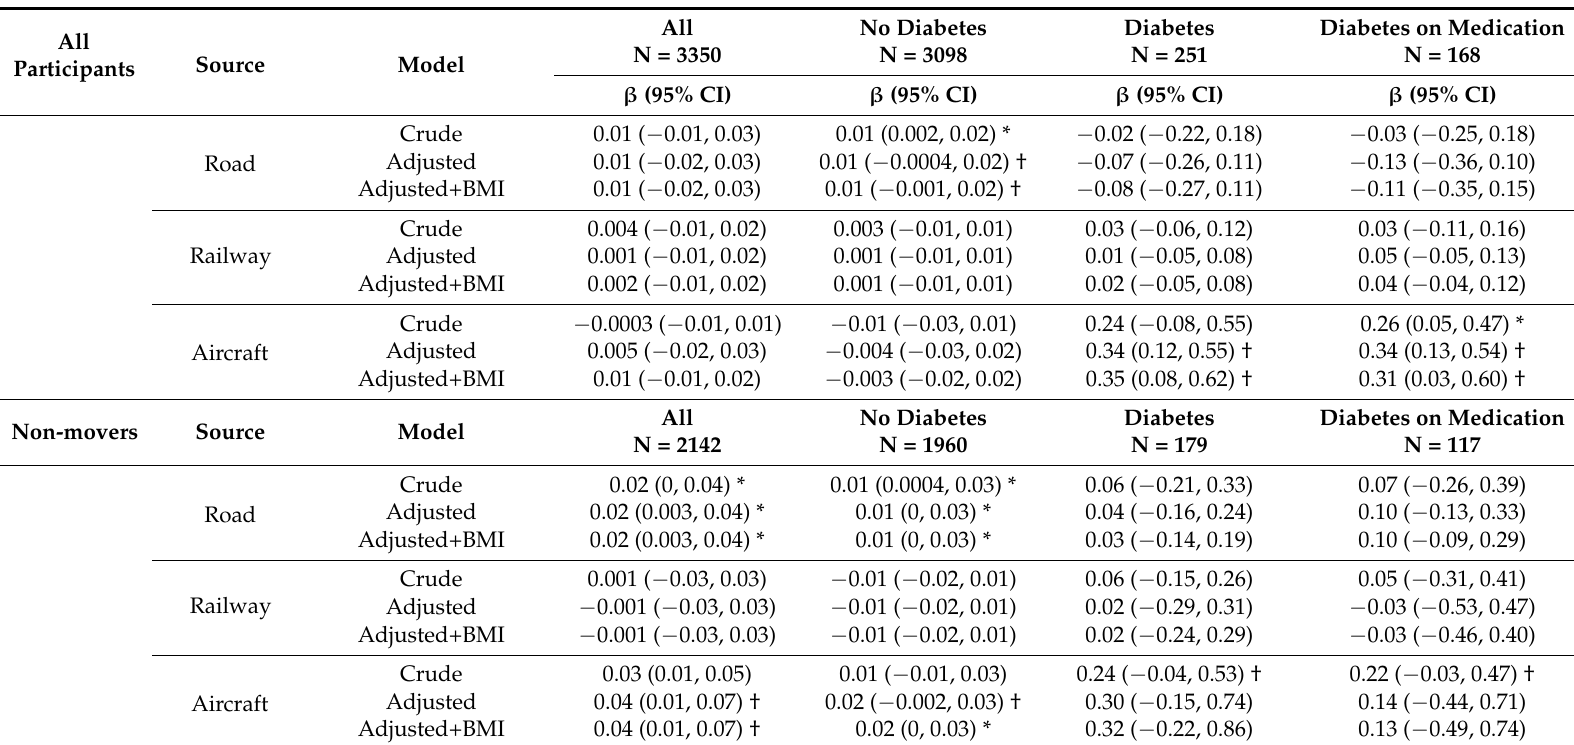
Table 2. Exposure to night-time transportation noise in 2001 (10 dB difference) and subsequent change in HbA1c